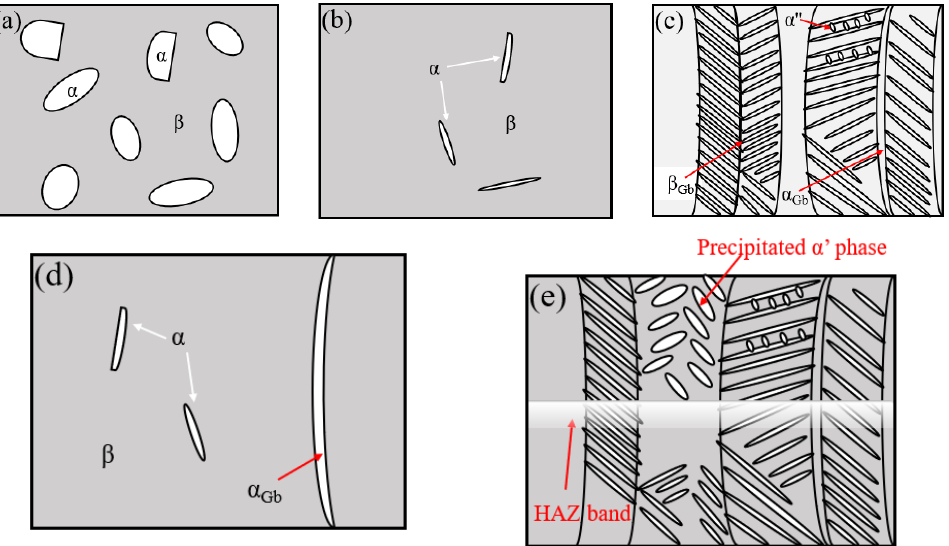
Figure 8. Schematic diagrams of martensitic transformation by LMwD. First layer: ( a ) room temperature, ( b ) above T β , and ( c ) cooling down below the M S . HAZ band formation: ( d ) the temperature rose to the T β , just in time. ( e ) Cooling down, below the M S .